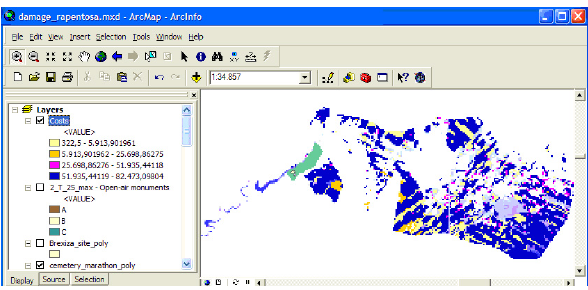
Figure 4. The flood risk map for the Rapentoza watershed for the scenario T = 100 years (the colours indicate the various levels of damage in monetary units).